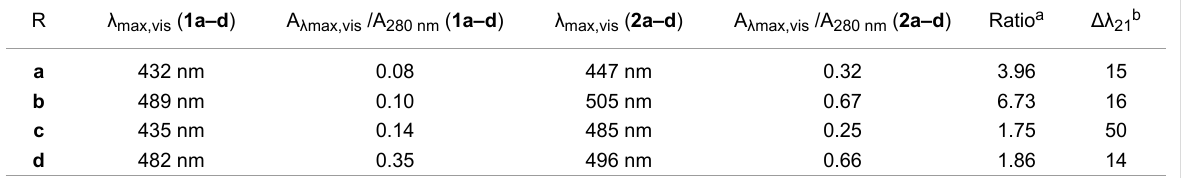
Table 1: Absorption characteristics of diarylethenes 1a–d and 2a–d .